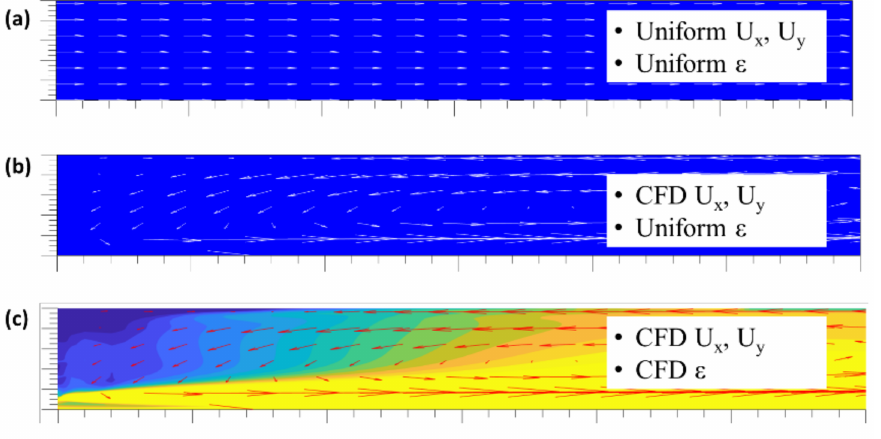
Figure 6. Illustration of the three investigated cases. ( c ) represents the realistic case of an inhomoge- neous velocity and turbulence, whereas ( a , b ) are idealized cases used to validate the method and discuss